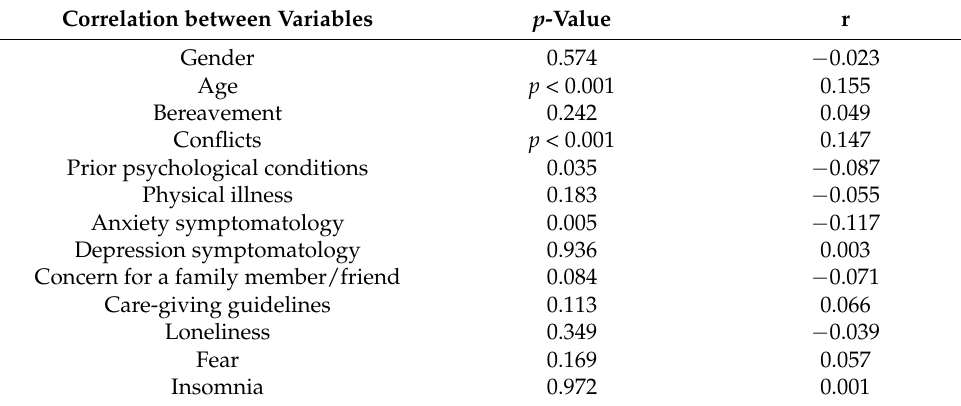
Table 4. Cross-tabulation of variables with date of